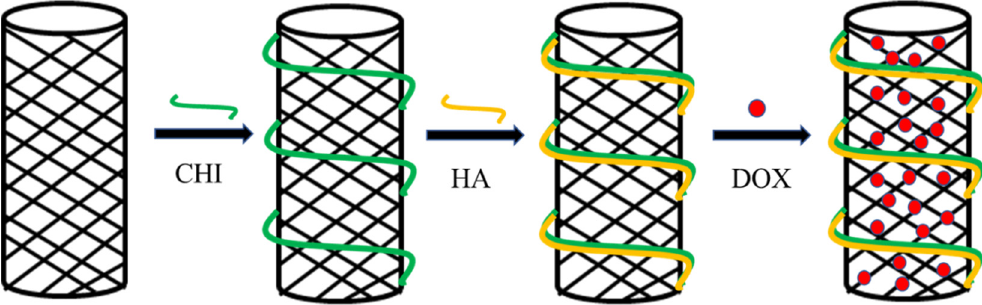
Figure 7. CHI- and HA-modified SWCNTs were used to deliver DOX. Abbreviations: CHI, chitosan; HA, hyaluronan; DOX, doxorubicin. Table 11. Various ligand-modified SWNTs and WWNTs are used to deliver cargos.